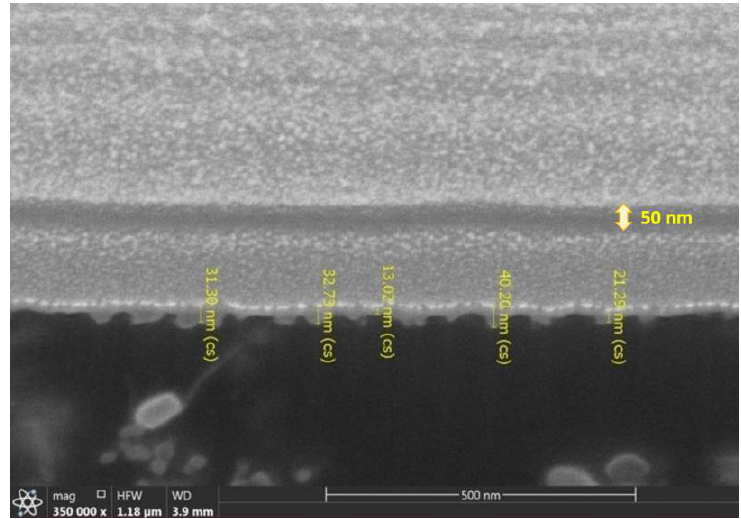
Figure 4. Schematic diagram of the ALD-coated ASIC (top); cross-section FIB image of 50 nm ALD-coated thin film.